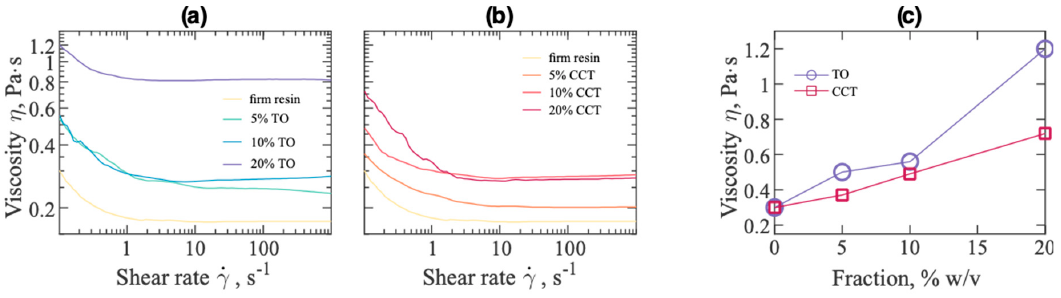
Figure 3. Viscosity of formulations of ( a ) TO composite and ( b ) CCT composite as a function of the shear rate and ( c ) filler content (at shear rate of 0.1 s − 1 ) at ambient temperature.